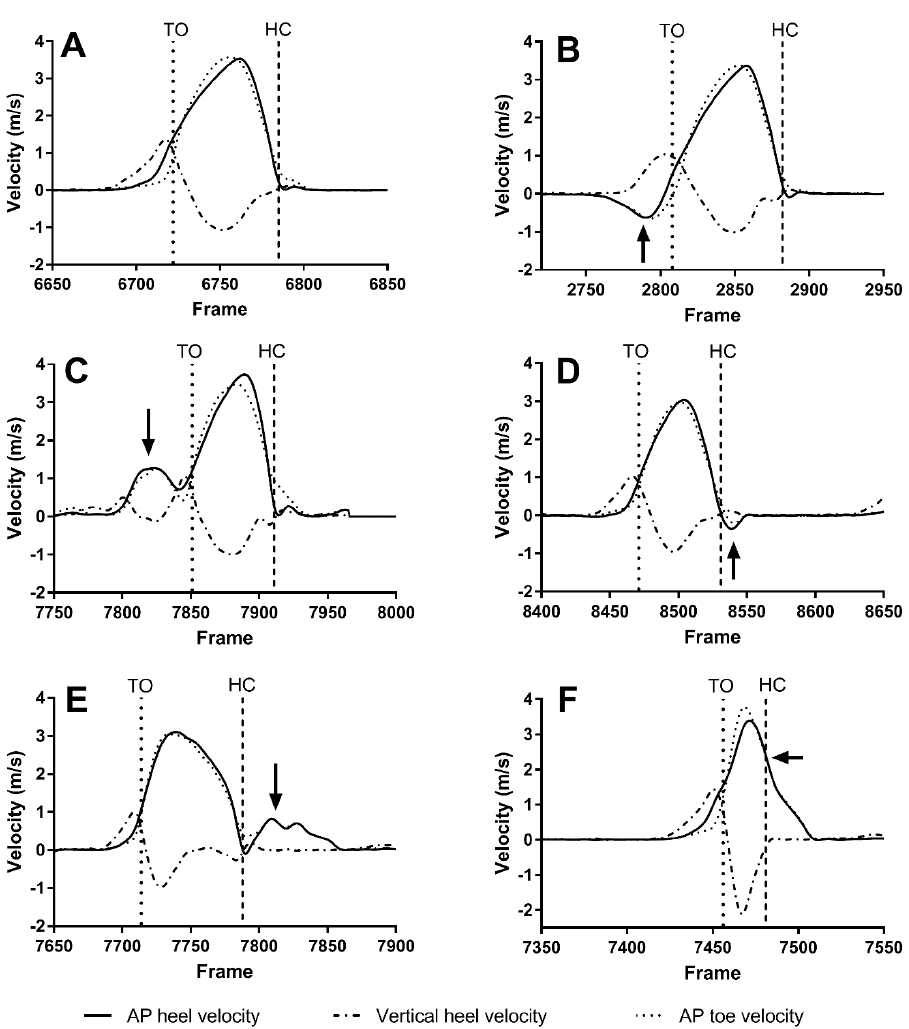
Figure 7. Velocity signal profiles of a normal step and the different types of slips observed. ( A ) Normal step. ( B ) Backward toe slip. ( C ) Forward toe slip. ( D ) Backward heel slip. ( E ) Forward heel slip. ( F ) Forward heel slip variant. The toe off (TO) and heel contact (HC) are shown as dashed vertical lines. The arrows indicate the key features of each